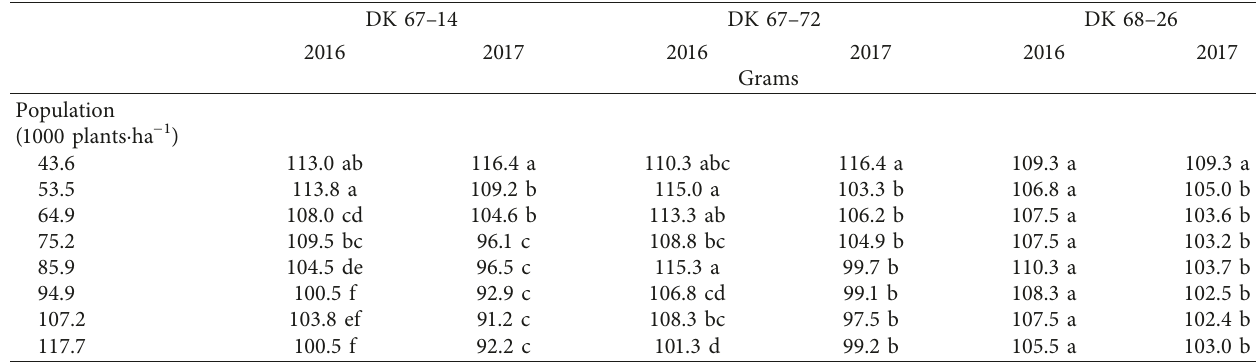
Table 5: Kernel weight of the three corn hybrids in 2016 and 2017.